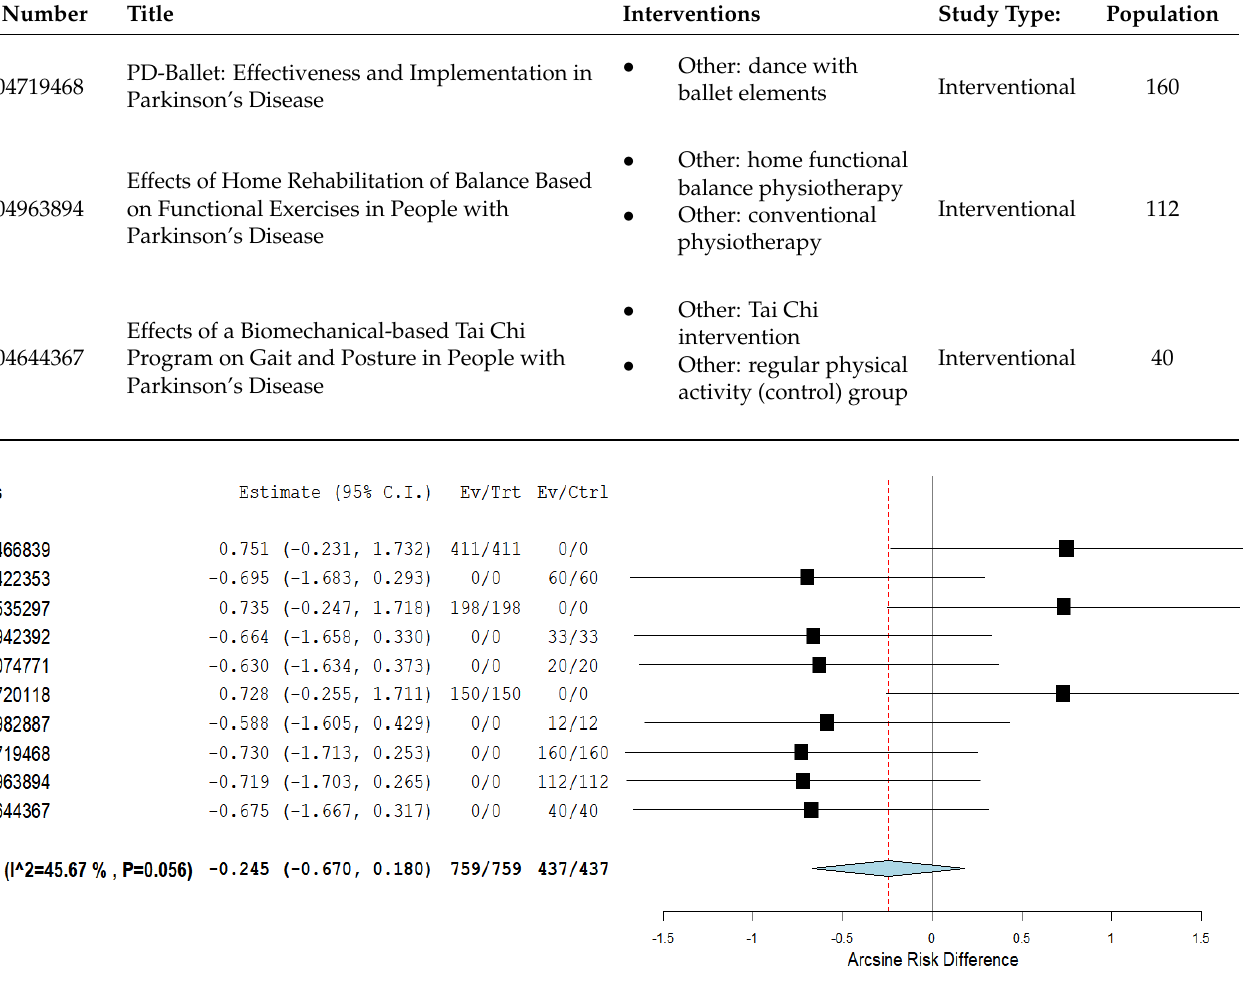
Figure 2. Meta-analysis of the data obtained from the identified clinical studies. Estimate lower- bound upper-bound std. error p -value-0.245-0.670 0.180 0.217 0.258. Heterogeneity. tau^2 Q (df = 9) Het. p -value I^2. 0.215 16.567 0.056 45.674.